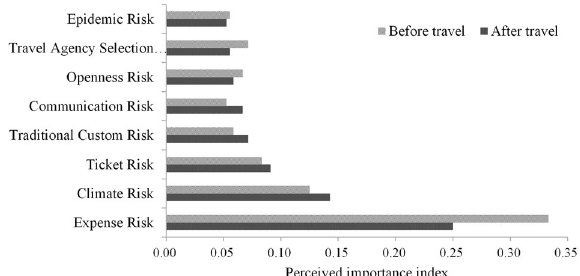
Fig. 10 Risks of no signi fi cant change in perceived importance before and after travel. The experiment results indicate that tourists ’ perception of these risks are relatively consistent before and